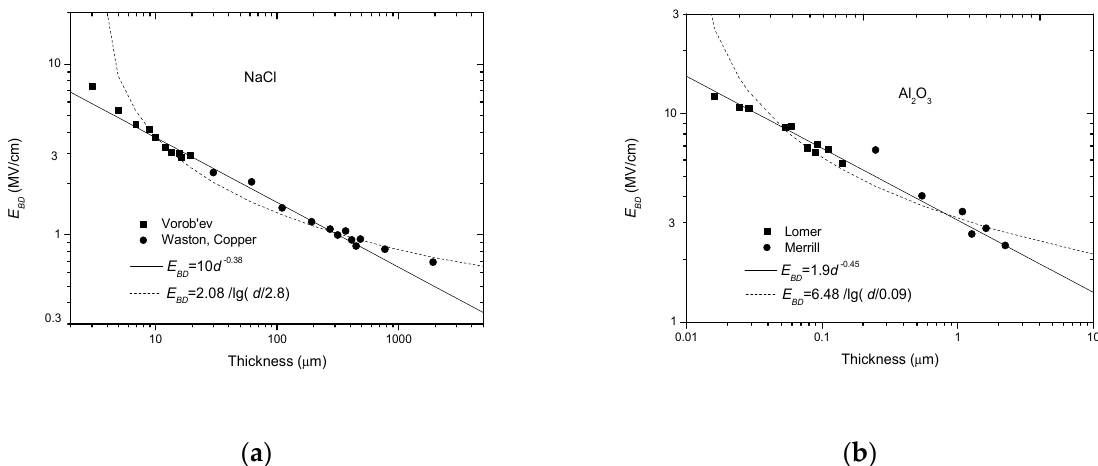
Figure 7. Comparison between the minus power relation and the reciprocal-single-logarithm relation with experimental data from O’Dwyer in a log-log coordinate system [33]. ( a ) NaCl, ( b ) Al 2 O 3 .